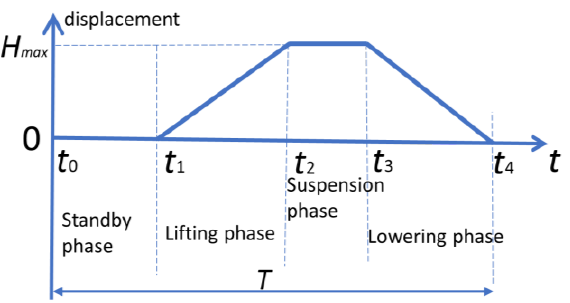
Figure 7. The duty cycle for the boom motion.